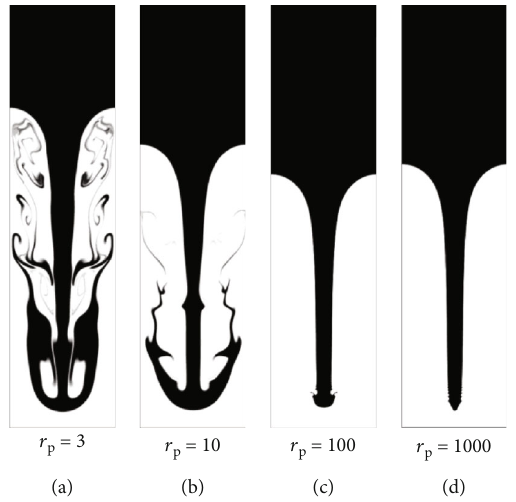
Figure 16: Snapshots of interface shape for di ff erent density ratios ( Re = 2048 and r